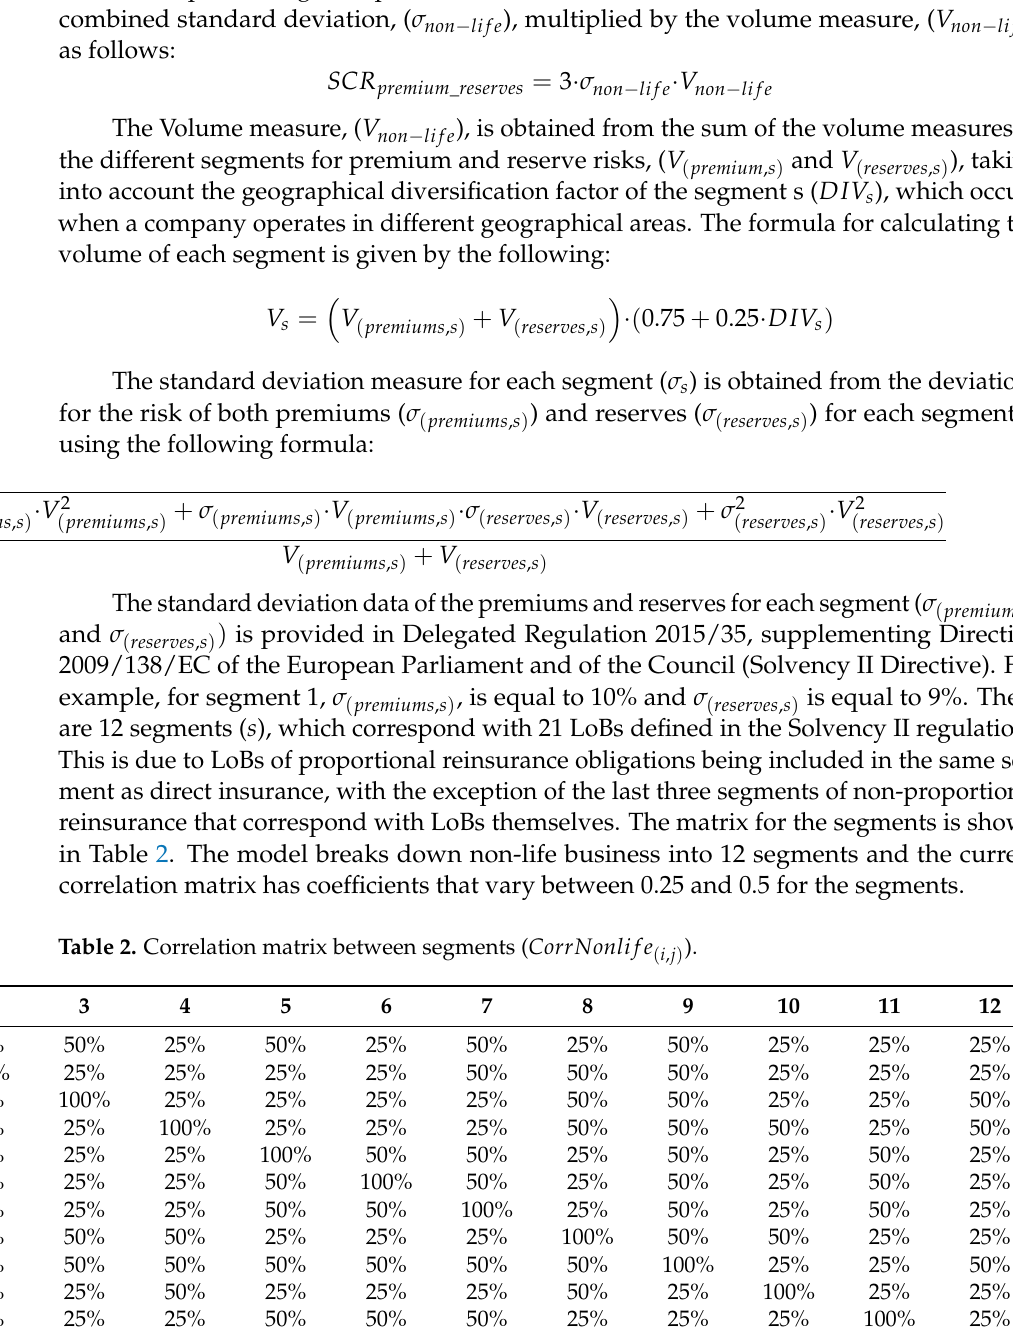
Table 1. Non-life risk correlation matrix under Solvency II regulation. Risk Premium and Reserve Risk CAT Risk Lapse Risk Premium and reserve risk 100% 25% 0 CAT risk 25% 100% 0 Lapse risk 0 0 100%